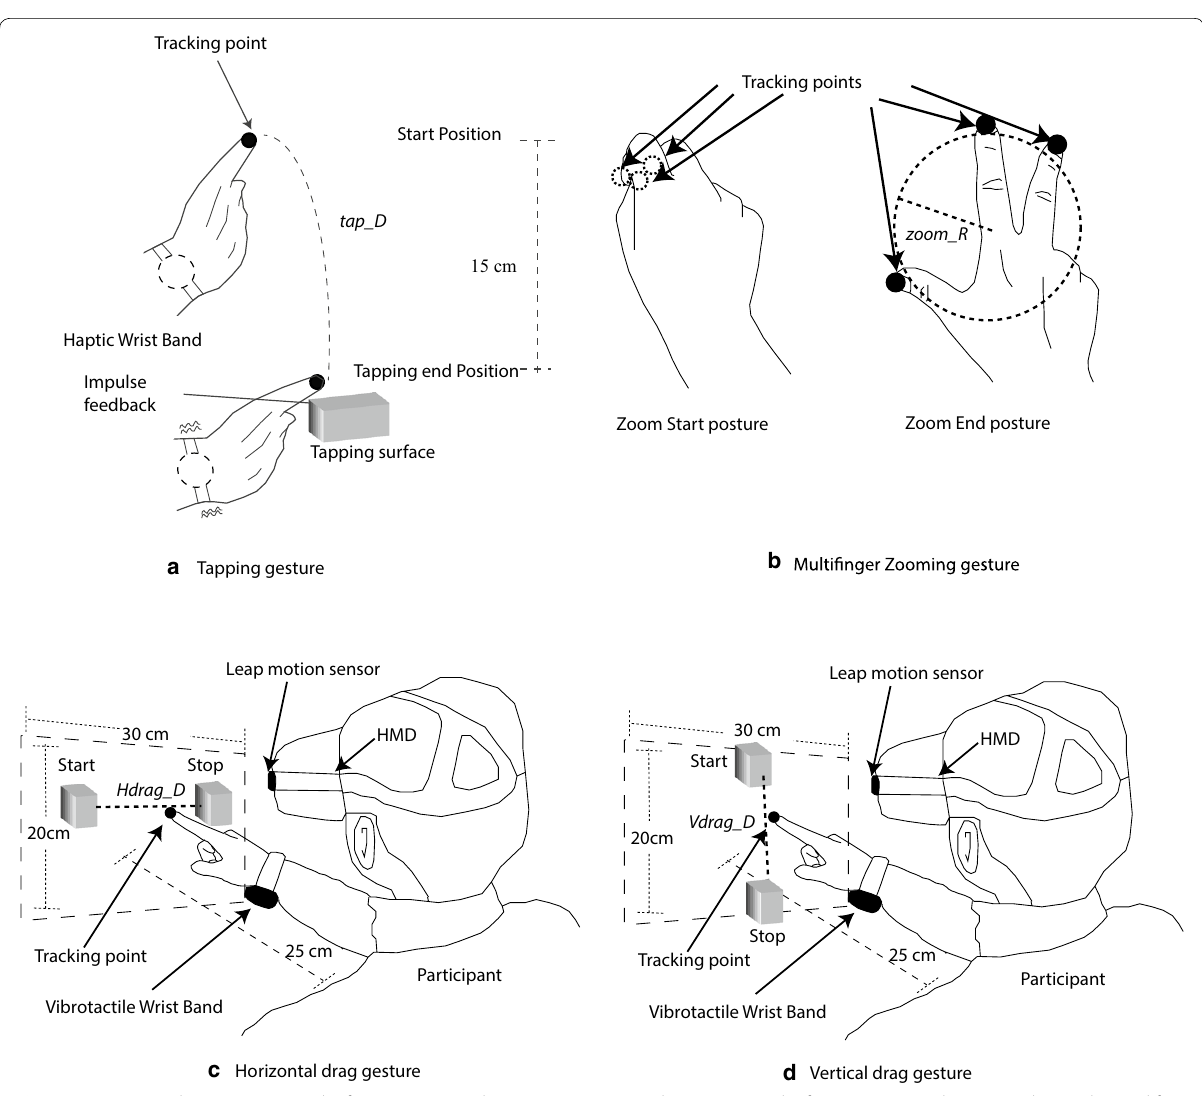
Fig. 2 Gestures, tracking positions and reference motion elements. Gestures, tracking points and reference motion elements to be synthesized for a tapping, b zooming, c horizontal drag, d vertical